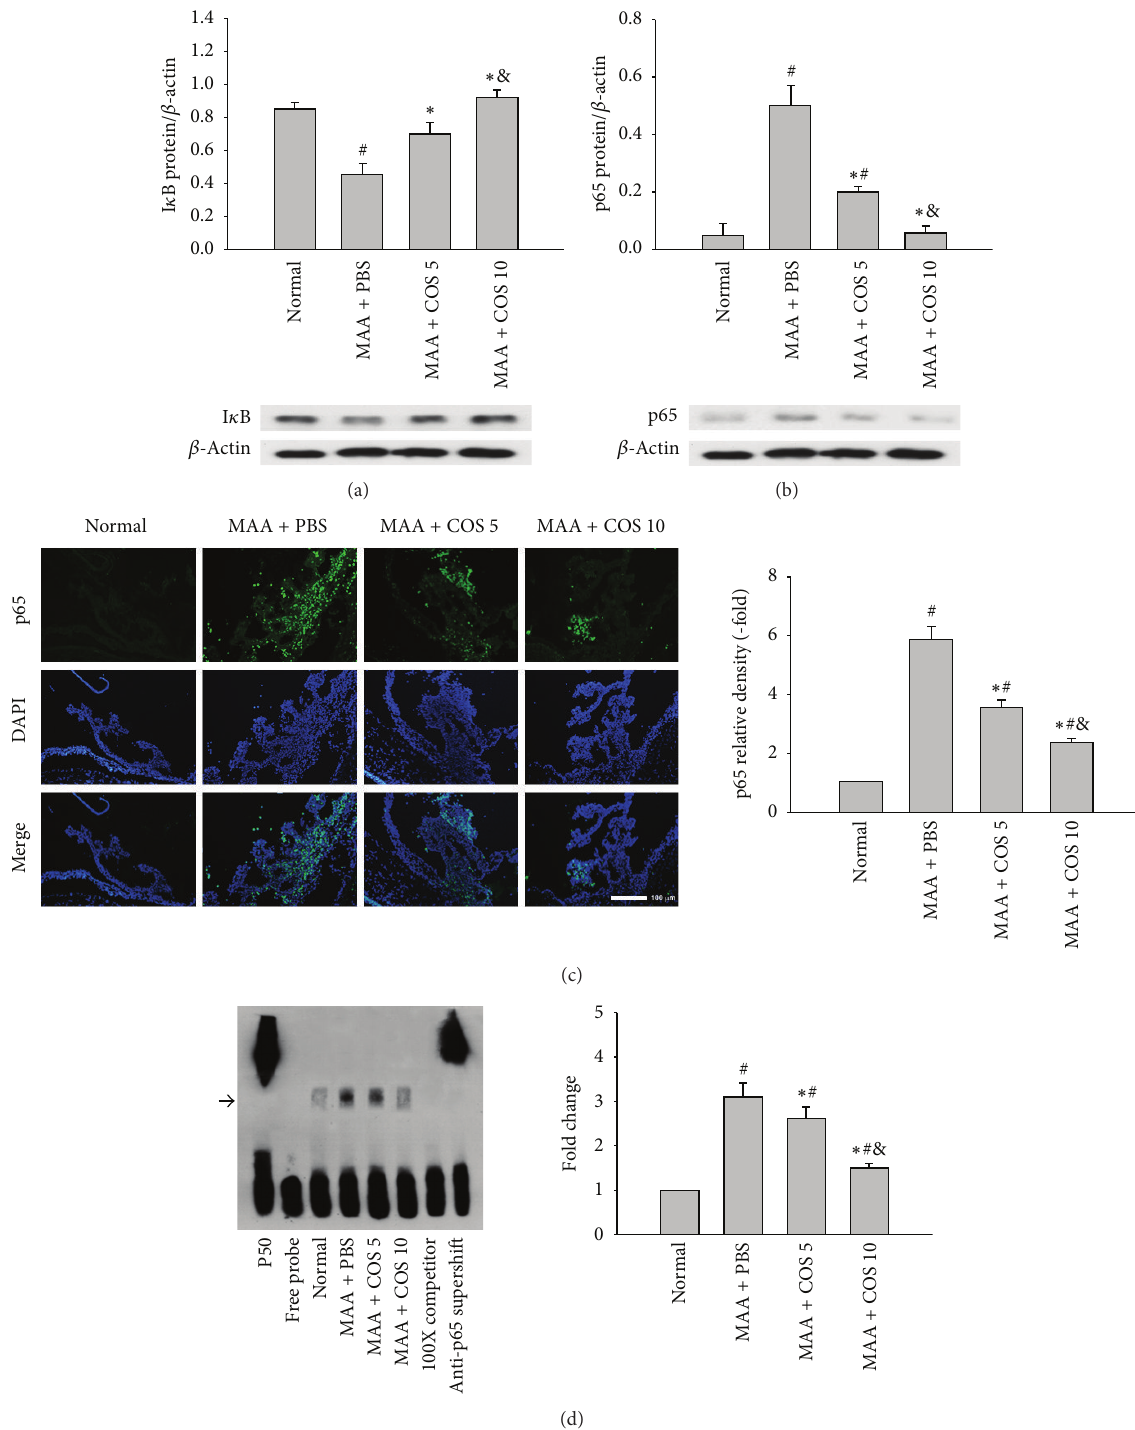
Figure 6: Effects of COS on the activation of NF- 𝜅 B in the ICB at day 14. Evaluation of (a) I 𝜅 B and (b) NF- 𝜅 B p65 in each group using western blot analysis. The Y scale represents the ratio of the I 𝜅 B or p65 blot density to the 𝛽 -actin blot density ( 𝑛 = 8 for each group). (c) Immunohistochemical study of the expression of the NF- 𝜅 B p65 subunit in retinas. The images represent three rats in each group. (d) The NF- 𝜅 B/DNA binding activity in the ICB was measured using EMSA. “Fold change” was defined as optic density of the PBS-treated, low-dose, or high-dose COS group divided by optic density of the normal group ( 𝑛 = 5 for each group) ( ∗ 𝑃 < 0.05 compared with the PBS-treated group; # 𝑃 < 0.05 compared with the normal group; & 𝑃 < 0.05 compared with the low-dose group by Kruskal-Wallis 𝐻 test with post hoc Dunn